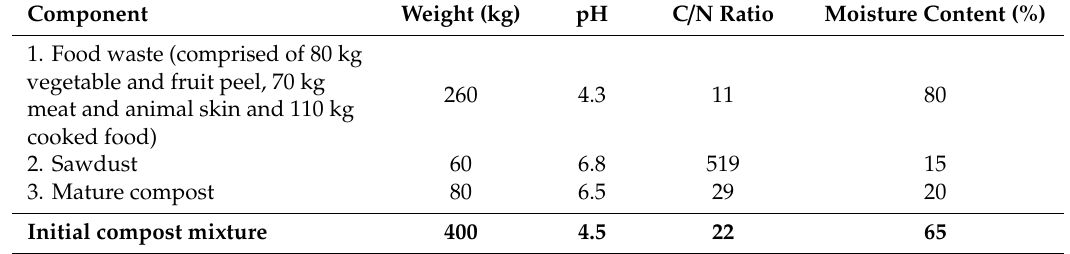
Table 1. Physicochemical characteristics of the 400 kg compost pile.